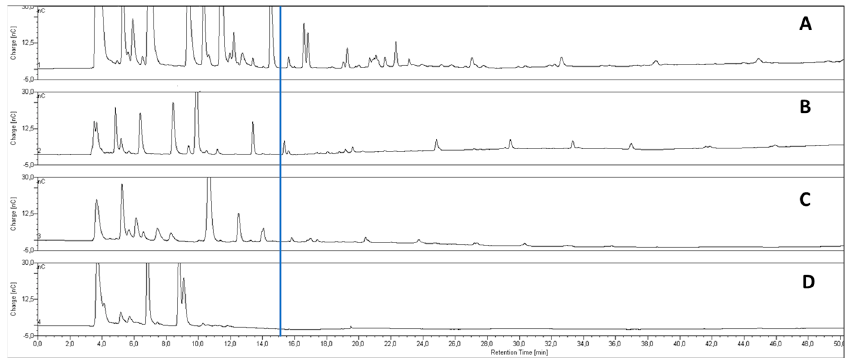
Figure 1. Chromatograms of flour samples. ( A ) Wheat flour; ( B ) rice flour; ( C ) emmer flour; ( D ) hemp flour.